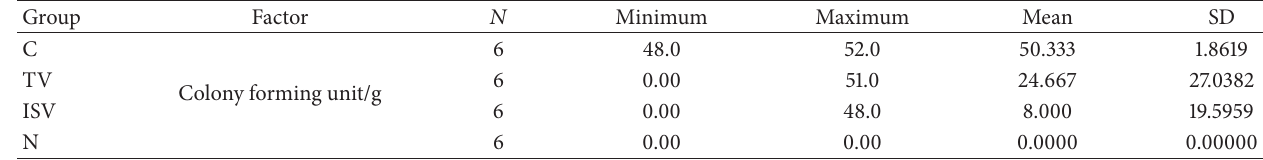
Table 5: The values of the colony forming units obtained from the cultured samples.